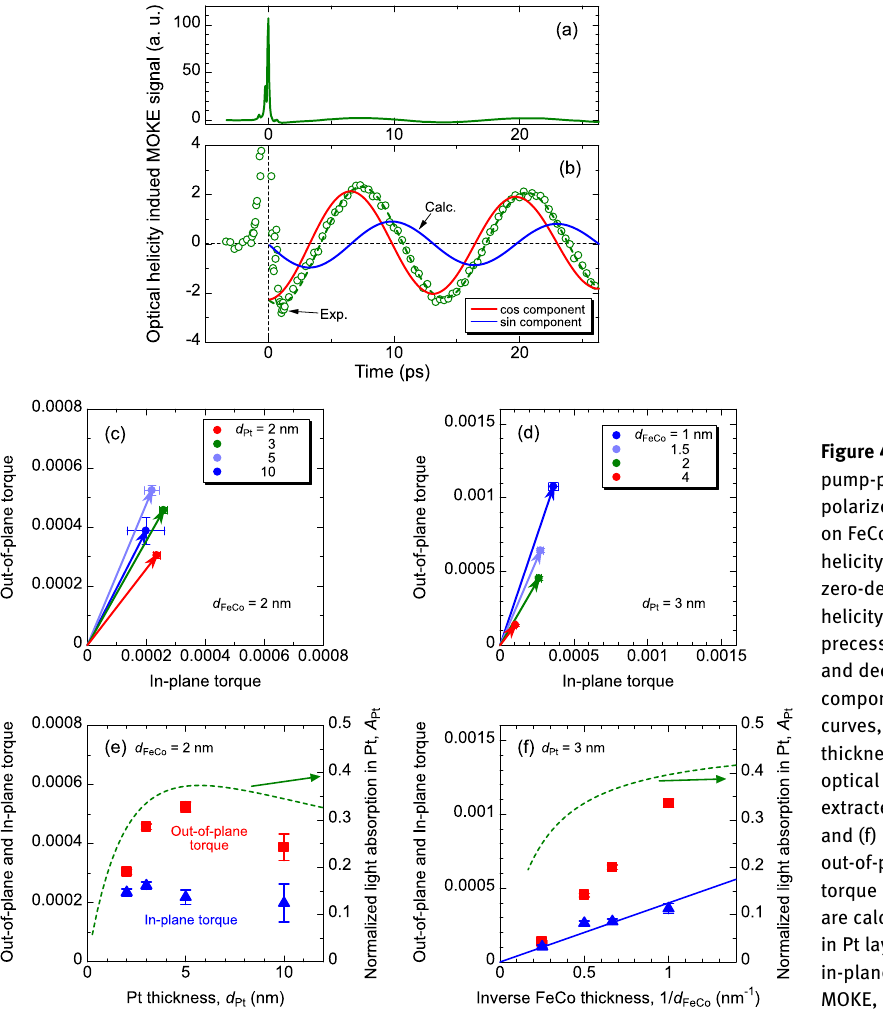
Figure 4(e) is similar to light absorption in Pt layer [dashed curve in Figure 4(e)], indicating that spin is generated by light absorption in Pt layer. In addition, the out-of-plane torque increased with decreasing d , as indicated in FeCo Figure 4(f). This is consistent with the nature of the inter- face effect of the spin-transfer torque. The spin-angular momentum conversion ef fi ciency in Pt layer calculated by